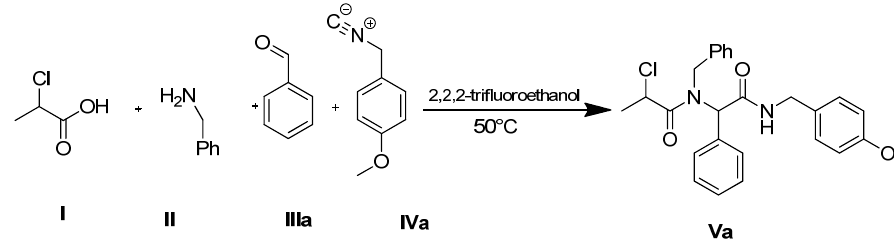
Scheme 2. Model Ugi reaction. Table 1. Influence of solvent on model Ugi